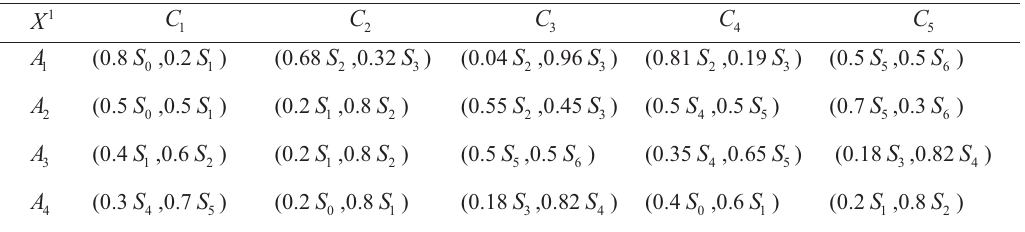
Table 1. The linguistic evaluation matrix 1 X provided by the decision maker